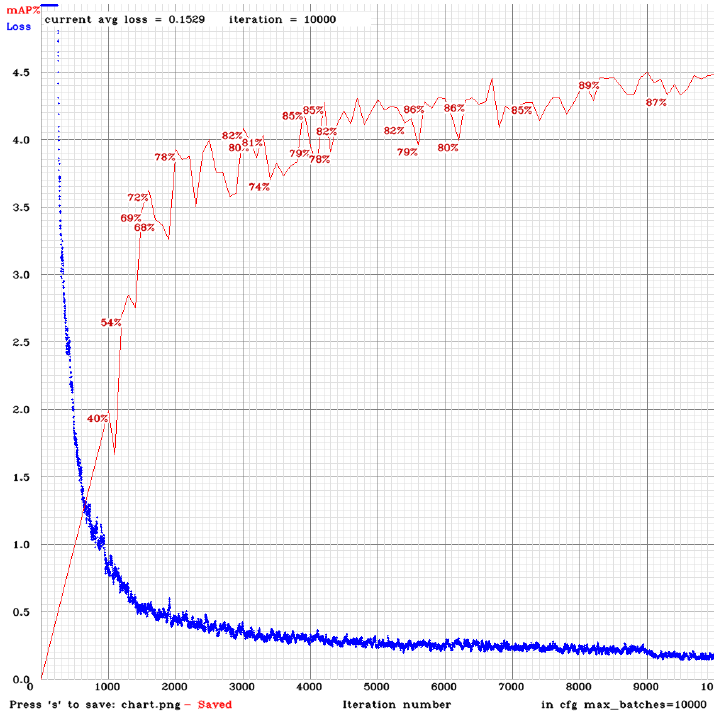
Figure 15. Training phase of the default